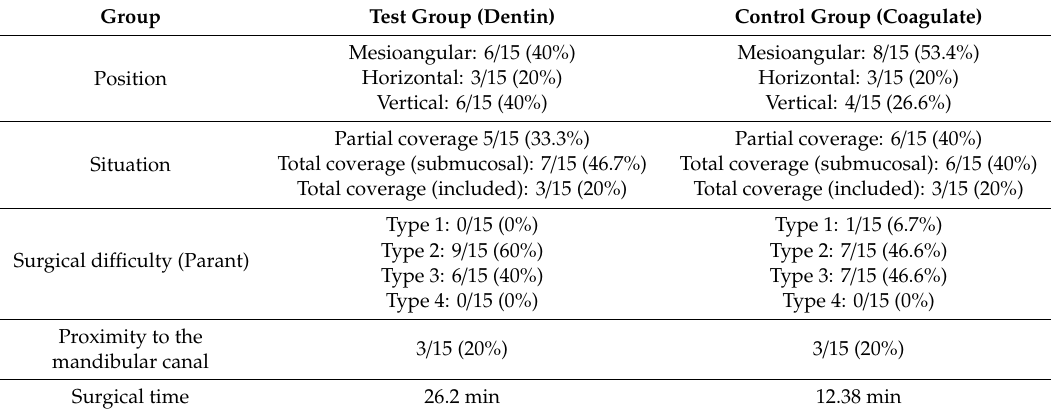
Table 1. Pre-operative and intra-operative characteristics in test and control groups.